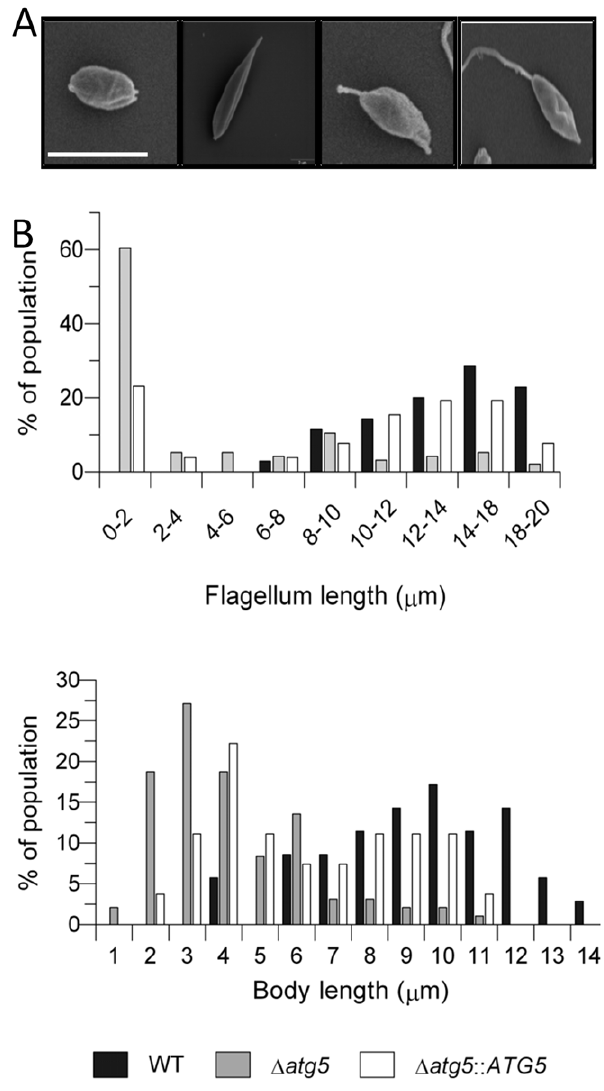
Figure 8. Morphology of D atg5 promastigotes. (A) SEM analysis of promastigote culture initiated with D atg5 isolated from a mouse lesion and cultured in nutrient-rich medium. Shown are ovoid and amastigote- like form (left); spindled-shaped form without an external flagellum (centre left panel) and with an external flagellum of varying lengths (centre right and right panels). Scale bar, 10 m m. (B) Distribution of flagella lengths and body lengths of stationary phase promastigotes. Data represent measurements from , 200 cells from each promastigote population.